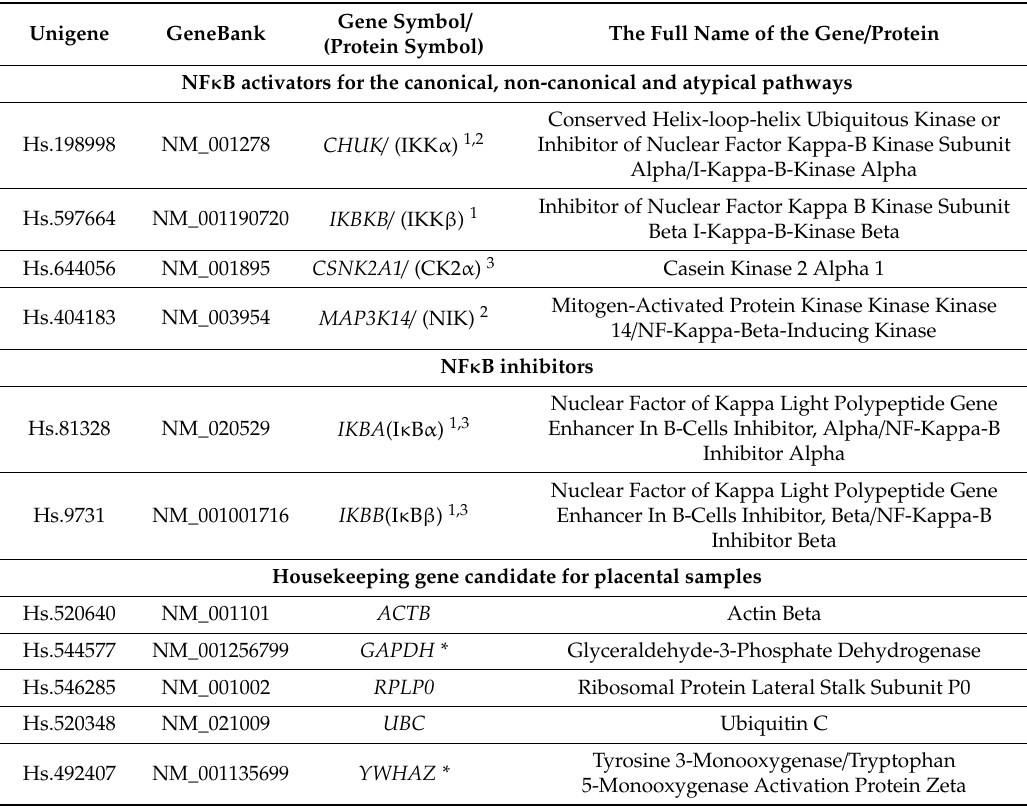
Table 4. Selected gene implicated in NF κ B regulation pathways and candidate housekeeping genes for placental samples. Gene Symbol / Unigene GeneBank The Full Name of the Gene / (Protein Symbol)